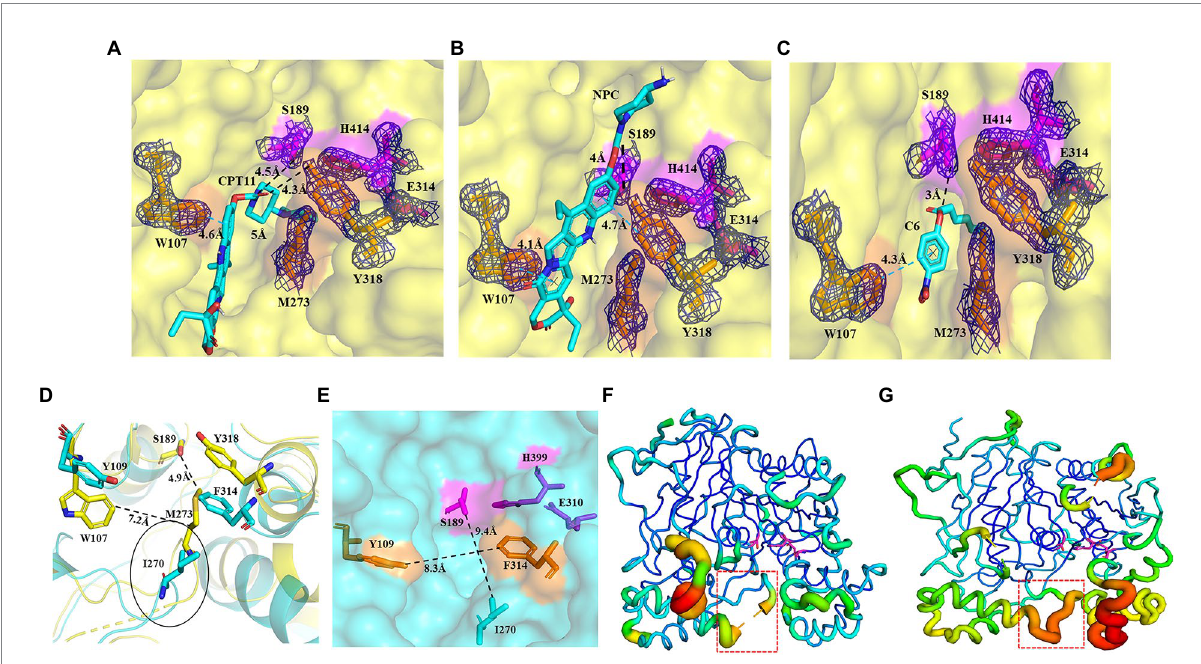
FIGURE 5 Binding patterns of E93 with different substrates in the Region A of catalytic pocket, simulated by AutoDock. (A–C) The docking of CPT11 (A) , NPC (B) , and p -NP hexanoate (C6) (C) into the catalytic pocket of E93. Magenta sticks represent the catalytic triad. The large-sized amino acids (Orange) involved in forming the tunnel structure of the Region A in E93 are shown with orange sticks. The interactions of E93_W107 and E93_ Y318 with the alcoholic group of CPT11, NPC, and C6 are shown. The interaction between the catalytic residue S189 and the carbonyl carbon of substrate is also demonstrated. The black dash line denotes hydrogen bond, and the blue dash line denotes π – π interaction. The electronic density map is contoured to 1.0 σ at the 2Fo-Fc map. (D) Structural superposition of the large amino acids within Region A of E93 (yellow) and the corresponding amino acids of pnbCE (cyan). The Region A of E93 has a width of 7.2 Å. The Special loop structure with significant conformational difference is specifically labeled. The distance between catalytic S189 and M273 in the special loop is 4.9 Å. (E) The large-sized amino acids involved in forming the tunnel structure of the Region A in pnbCE are shown with orange sticks. The catalytic triad of pnbCE is highlighted by the magenta sticks. The Region A of pnbCE has a width of 8.3 Å. The distance between pnbCE_I270, corresponding to E93_M273, and the catalytic resideue, S189 in pnbCE, is 9.4 Å. The dash line in panels (D,E) was used to show the distance between two amino acids. (F,G) B-factor analysis of E93 (F) and pnbCE (G) . The thickness of coil represents the flexibility of the structure. The thicker the coil is, the higher flexibility the structure is. The catalytic triad residues of E93 and pnbCE are shown as sticks. The loop with high flexibility in catalytic center of two enzymes is labeled with red